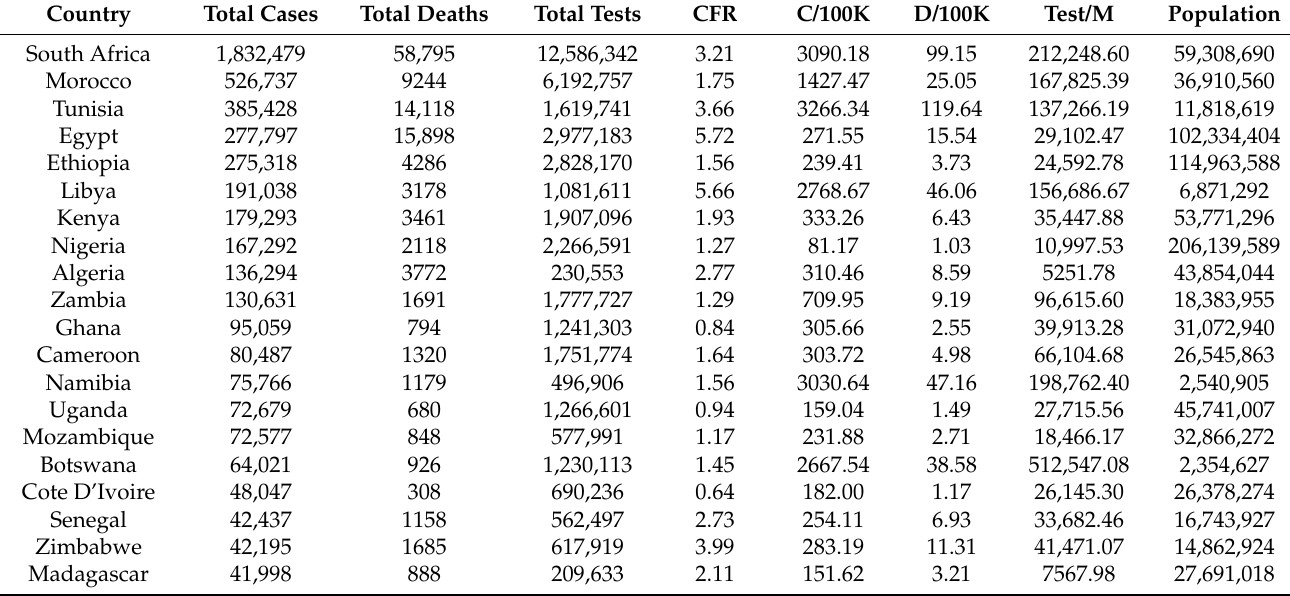
Table 1. Top 20 countries in Africa with highest COVID-19 infections